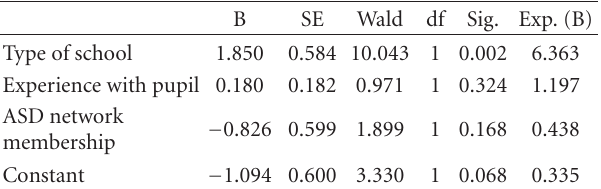
Table 5: Direct logistic regression on need for